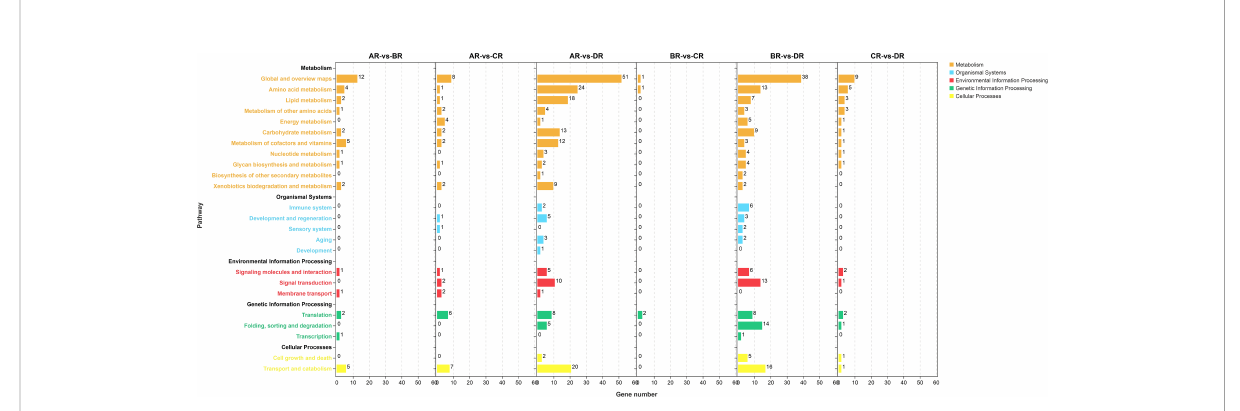
FIGURE 4 KEGG enrichment of DEGs between growth stages in S. nudus